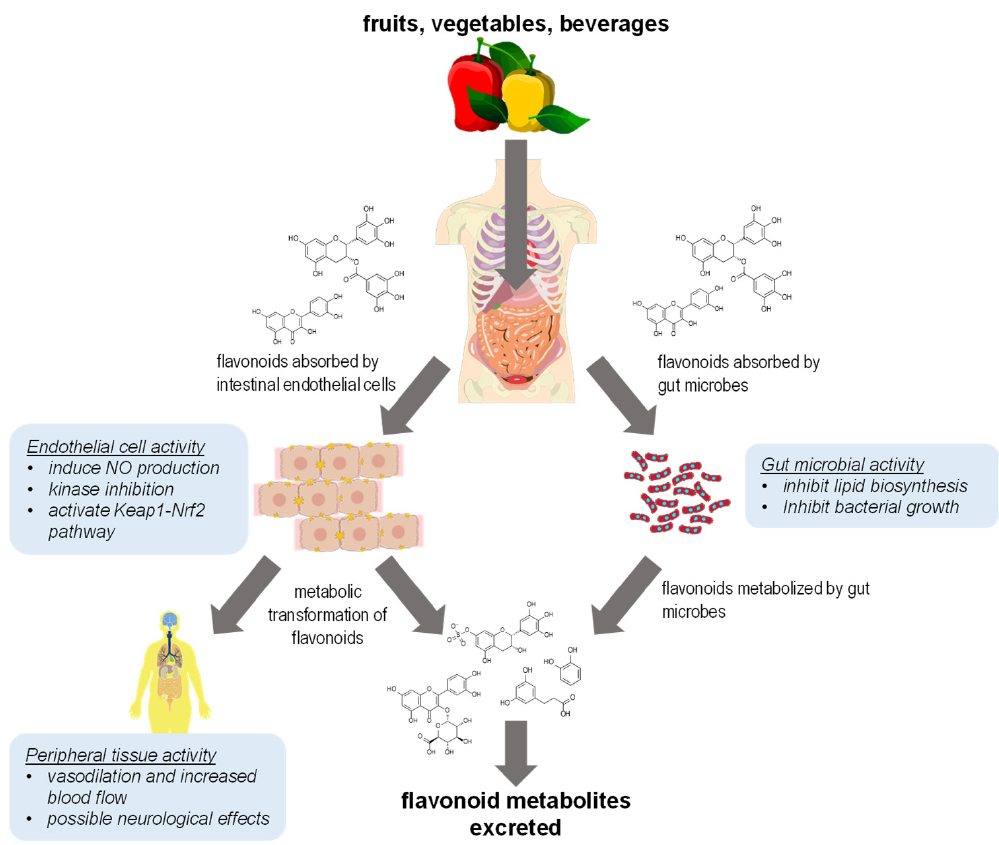
Figure 1. A summary of the most reasonable primary routes of flavonoid bioactivity in humans. Flavonoids will exhibit most of their bioactivity in intestinal epithelial cells and in gut microbial cells. After metabolic degradation by intestinal microflora, microbial metabolites of flavonoids are absorbed by the intestines and excreted.